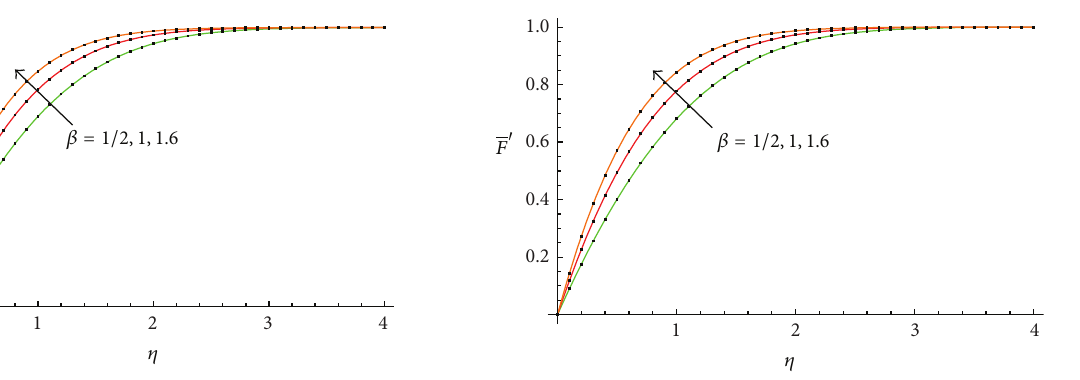
Figure 4: Comparison between the velocity profile obtained from (51), (59), and (67) and numerical results for 𝛽 = 1/2 , 1, and 1.6, respectively: —numerical; ... OHAM solution.